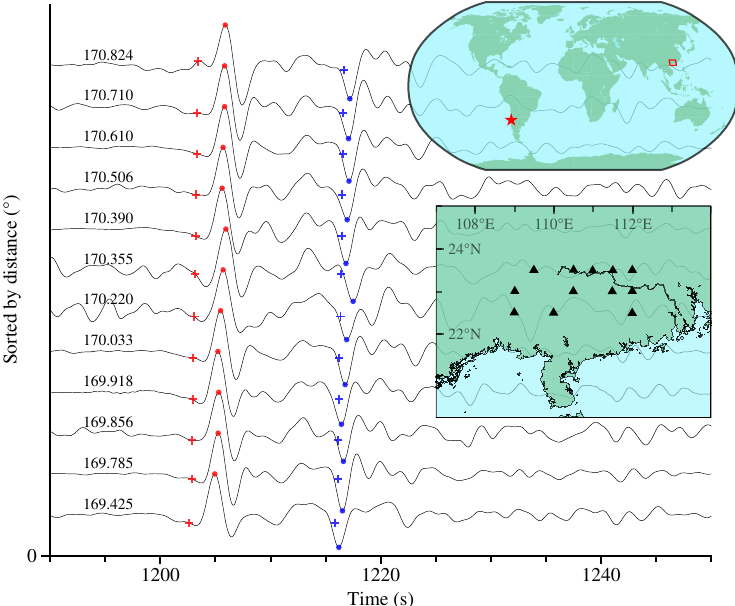
Figure 2. Observed seismograms and picks of PKIKP (red filled circle) and pPKIKP (blue filled circle) phases in portable network (red quadrilateral) for the event occurred on 23 August 2014 Mw 6.1, Chile (red star). The red and blue plus sign represent the theoretic arrival time of PKIKP and pPKIKP. The observed traveltime are marked with a red and blue filled circle,